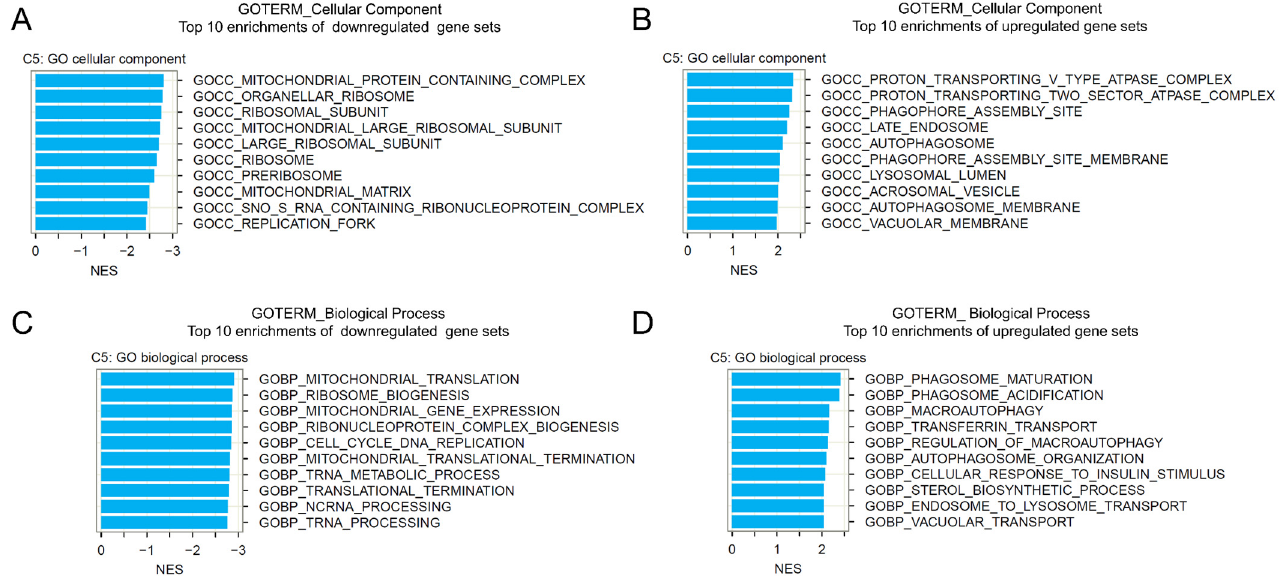
Figure 5. Gene set enrichment analysis (GSEA) of BI-2536-induced mRNA recurrences: Recurrence (REC) gene list, Gene Ontology (GO), Cellular Component (CC), and Biological Process (BP) gene sets were used for the GSEA analysis. The top 10 downregulated and upregulated CC ( A , B ) and BP ( C , D ) terms are shown (with false discovery rate (FDR) q -values of <0.25 from the GSEA analysis).